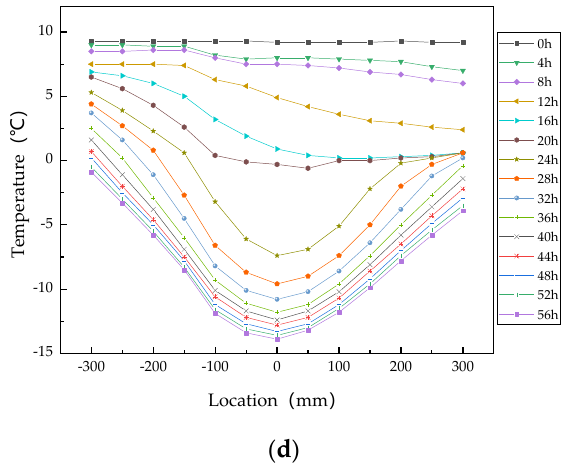
Figure 11. Spatial distribution of temperature on the C axis at: ( a ) 0 m/d; ( b ) 3 m/d; ( c ) 6 m/d; ( d ) 9 m/d.